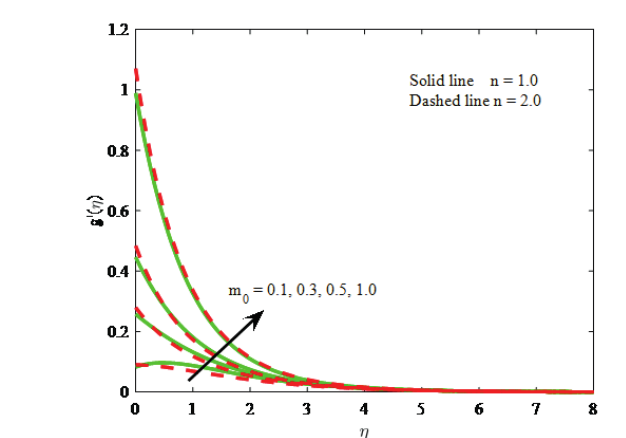
Fig. 11: Impact of m 0 on micro-rotation velocity.